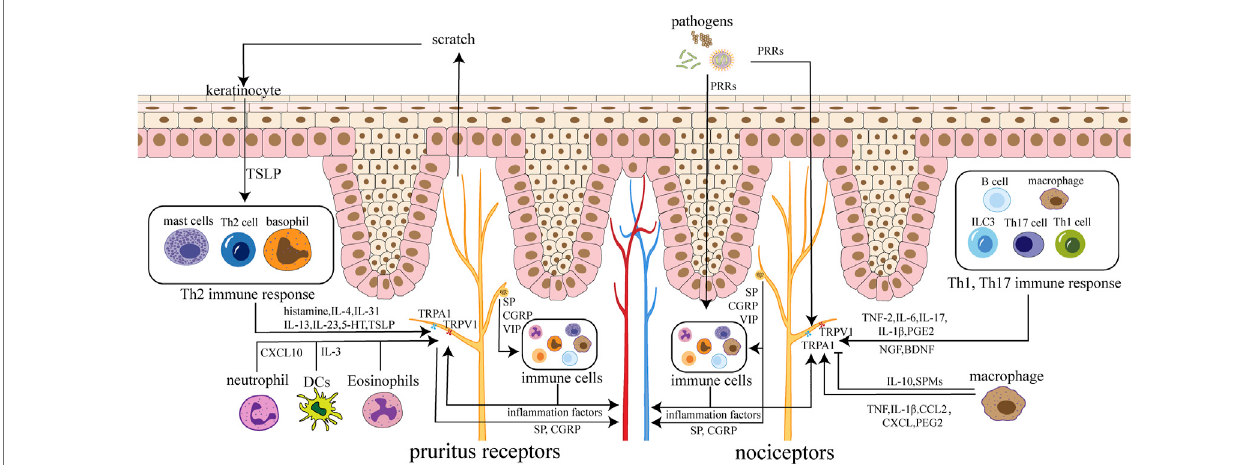
FIGURE 1 | Neuroimmune circuits in skin. Immune cells activate receptors and channels on sensory neurons in the skin by secreting cytokines, chemokines, and lipids, leading to itching and pain. Nerve endings can also regulate immune cells by releasing SP, CGRP, VIP and other neuropeptides. Neuropeptides and factors can act on the skin and blood vessels, causing in fl ammation and edema. Pathogens can stimulate nociceptors directly or by in fl ammatory cytokines from immune cells. Pruritus receptors ’ activation cause scratch, which leads to the destruction of keratinocytes with TSLP released, triggering ampli fi cation effect. Nociceptors are mainly involved in Th1 and Th17 immune responses, while pruritus receptors are mainly involved in Th2 immune responses.